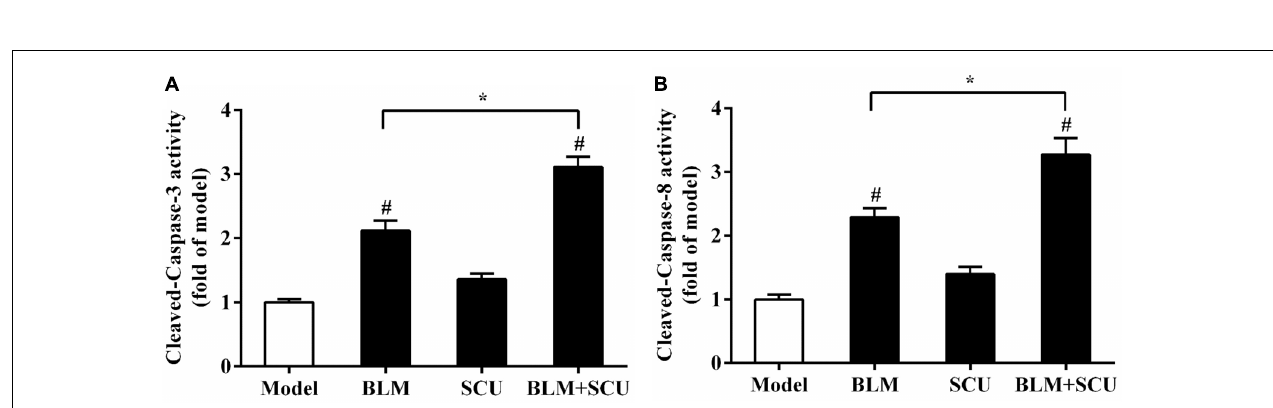
FIGURE 4 | SCU enhanced the anti-tumor effect of BLM by modulating the activities of cleaved-caspase-3 and cleaved-caspase-8 in tumor-bearing mice. The activities of cleaved-caspase-3 (A) and cleaved-caspase-8 (B) were measured. Data are presented as the mean ± SD of the changes compared to the model group. ( n = 8). # p < 0.05 compared with model group; ∗ p < 0.05 compared with BLM